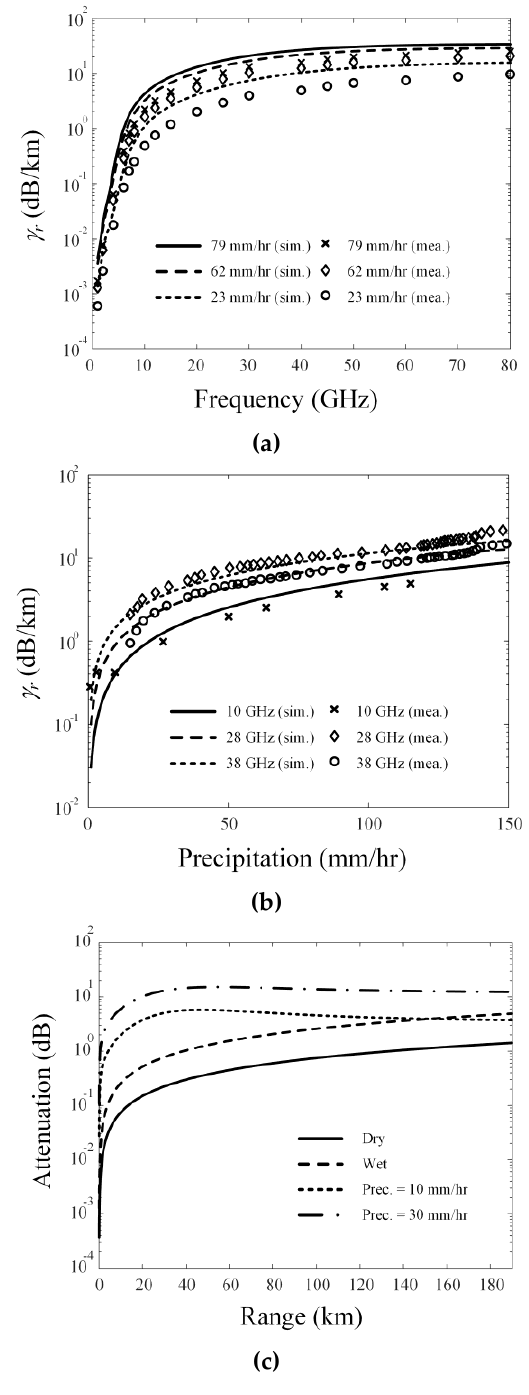
Figure 4. Calculated atmospheric gas and rainfall attenuation results: ( a ) rainfall attenuation accord- ing to frequency; ( b ) rainfall attenuation according to precipitation; ( c ) gas and rainfall attenuation according to range.